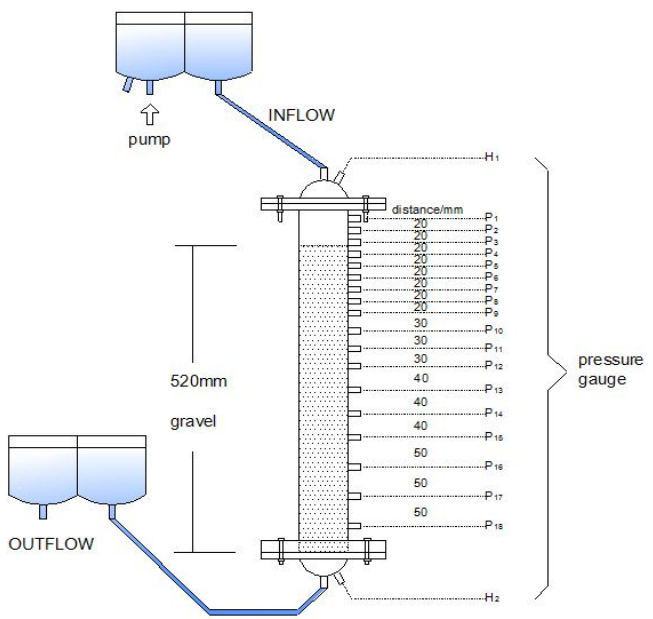
Figure 1. Schematic diagram of aquifer recharge managed simulated